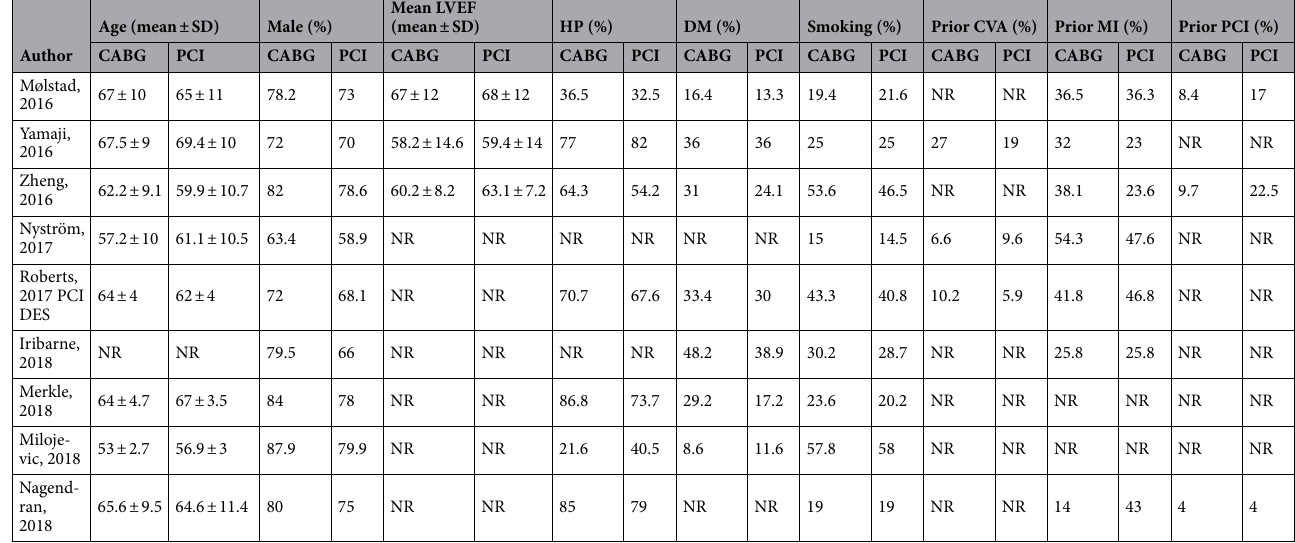
Table 3. Demographic data from the included studies (part 2). CABG coronary arterial bypass graft, CVA cerebrovascular accident, DES drug eluting stents, DM diabetes, HP hypertension, LVEF left ventricular ejection fraction, MI myocardial infarction, NR not reported, PCI percutaneous coronary intervention, SD standard